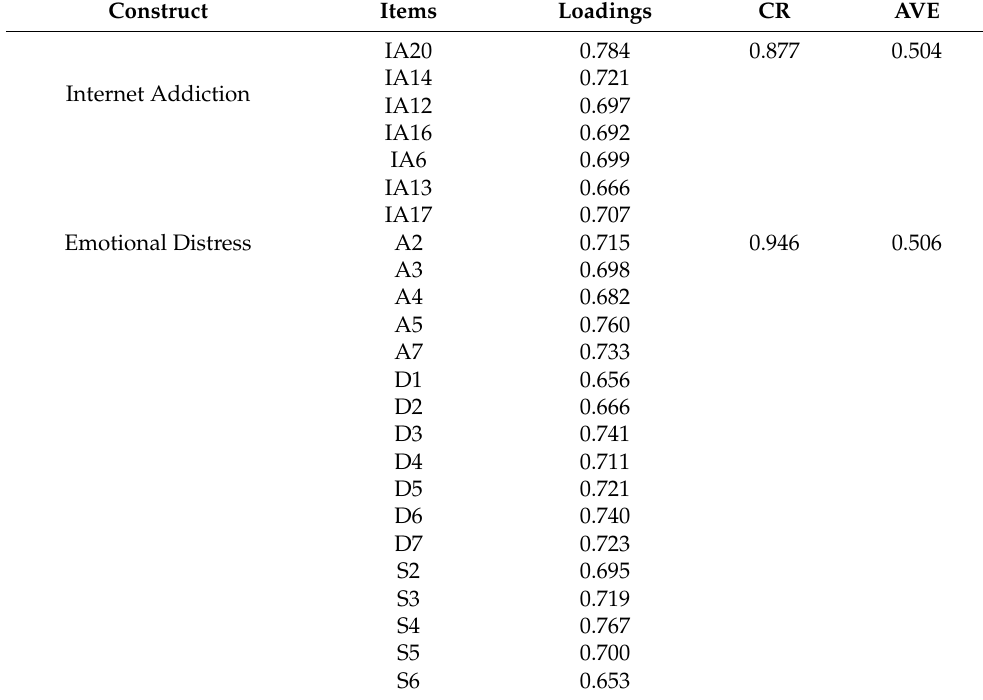
Table 1. Results of measurement model.